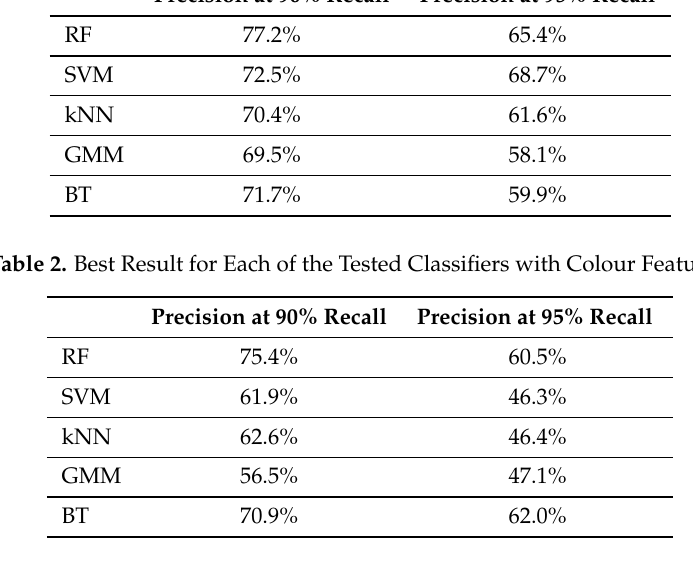
Table 3. Best Result for Each of the Tested Classifiers with Both Colour and Texture Features Combined.